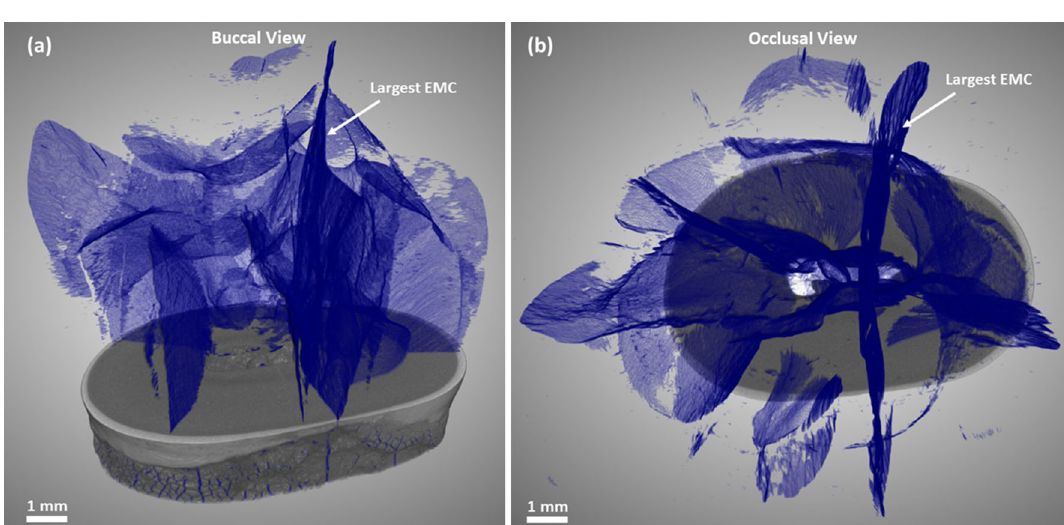
Figure 5. 3D virtual cut through the tooth showing an intricate network of cracks (blue): ( a ) buccal view and ( b ) occlusal view. The largest EMC is